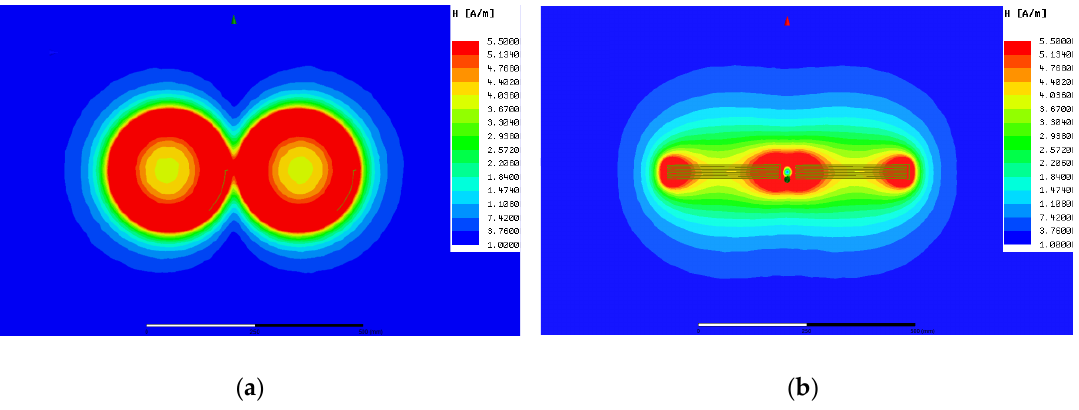
Figure 3. Diagram of magnetic field distribution. ( a ) Overhead view ( b ) Orthographic view.